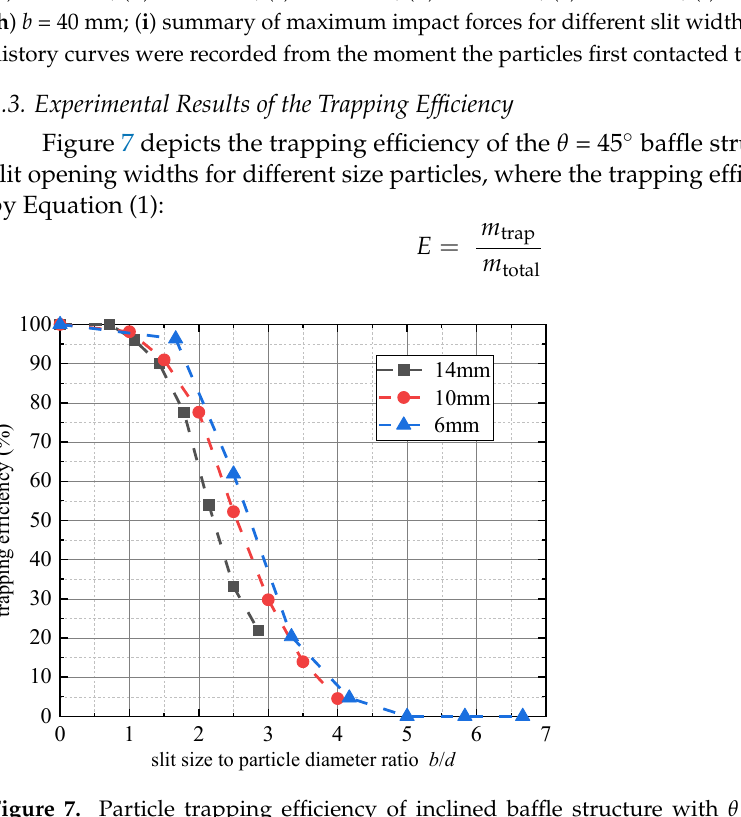
Figure 7. Particle trapping efficiency of inclined baffle structure with θ = 45° under different slit widths.